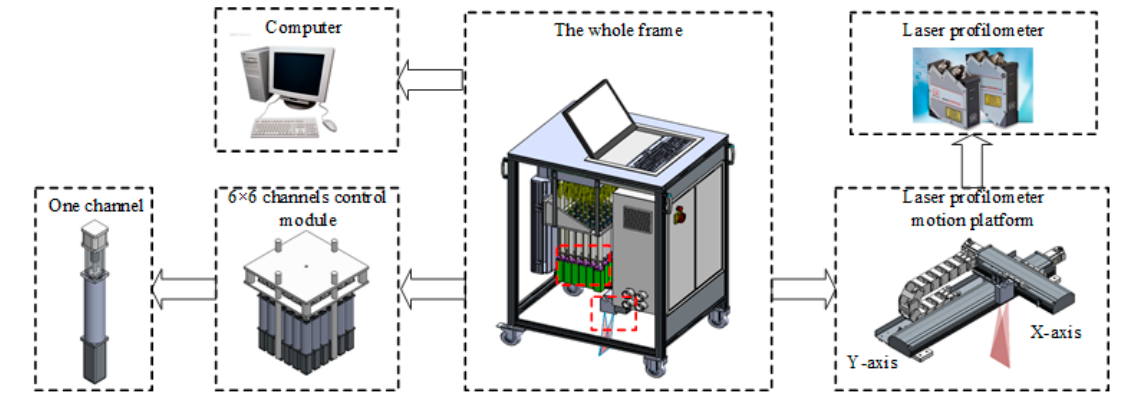
Figure 13. Mechanical structure of the system.